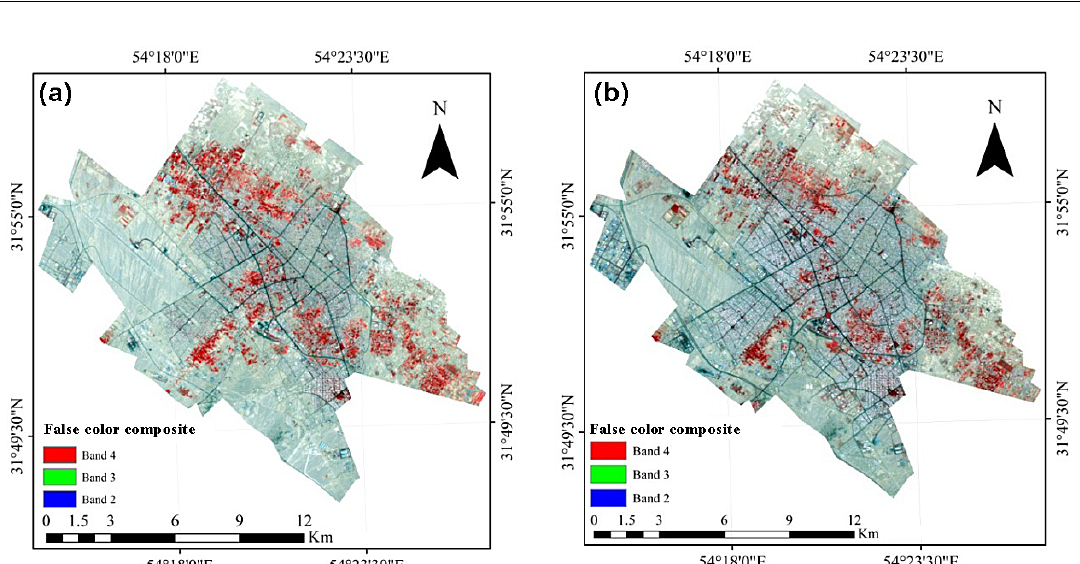
Figure 3. False color composite (bands 2, 3 and 4) image of Landsat TM data of Yazd city: (a) 8 August 1998, (b) 6 August